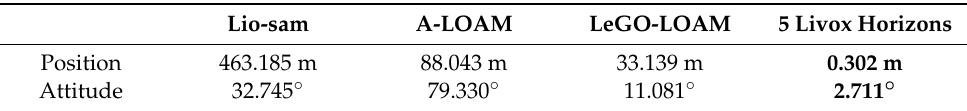
Table 2. End-to-end position and attitude errors for the small loop at severe situations. (Compared with Ouster